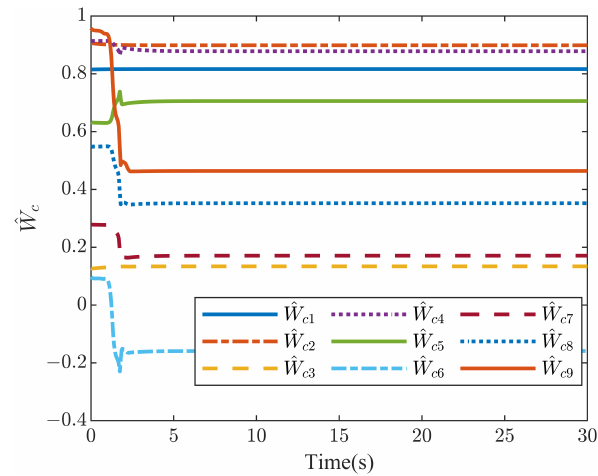
Figure 10. Weights of the critic network.